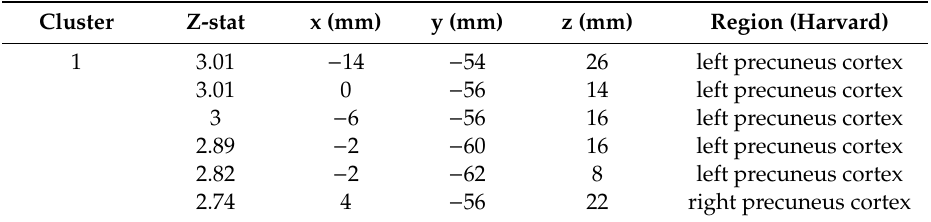
Figure 2. Ciswomen vs. transmen. Between-group analysis during the face presentation (female → male) shows clusters of significantly ( p <0.01) higher blood oxygen level dependent (BOLD) effect in transmen group when compared with ciswomen. The activations are included in the precuneus. Cluster formation threshold was set at 2.3 of Z statistic value. Coordinates are reported in Montreal Neurological Institute space. Table 2. Clusters of significantly ( p < 0.01) higher di ff erential activation in the transmen Group when compared with ciswomen for female → male face